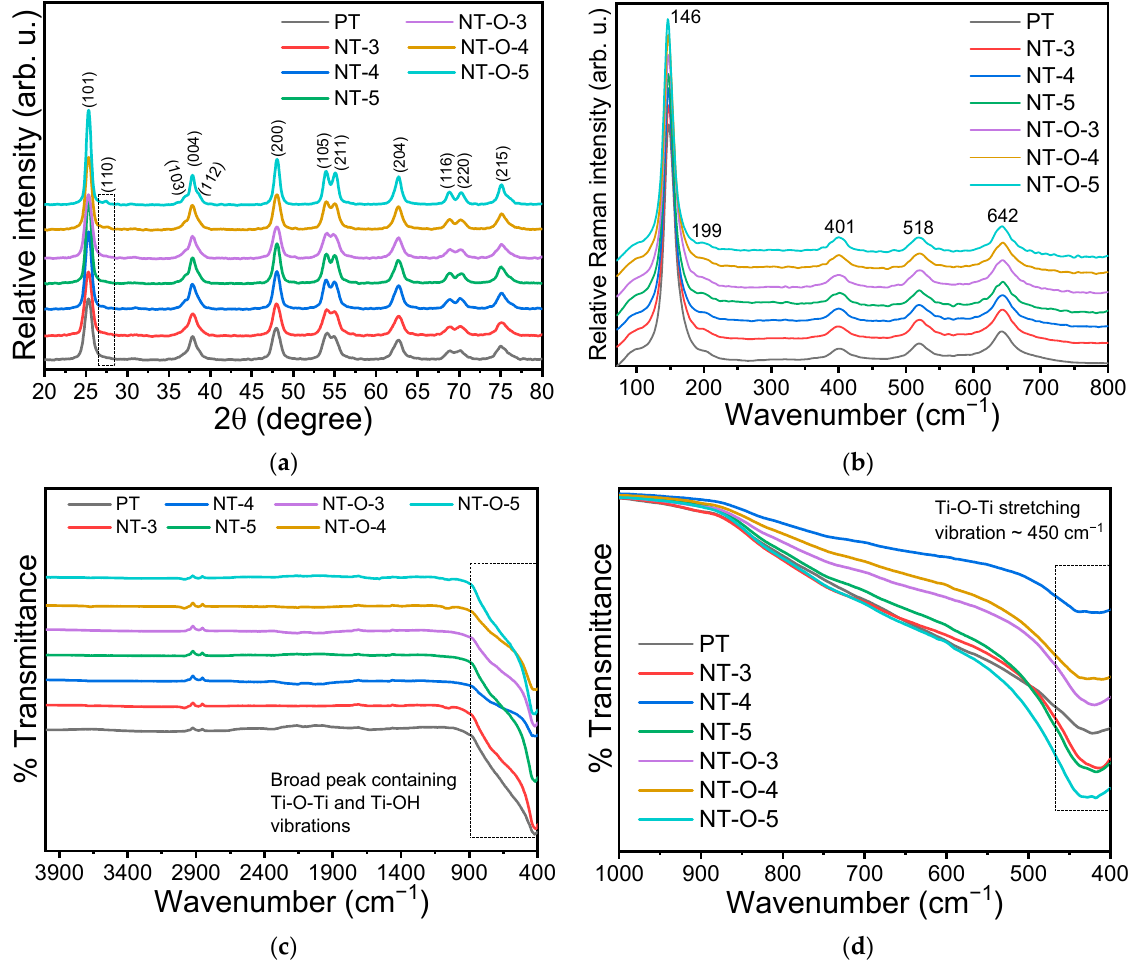
Figure 1. Results of ( a ) XRD, ( b ) Raman, and ( c ) FTIR analyses of investigated solids. Graph ( d ) shows zoomed FTIR spectra in the range of 1000–400 cm − 1 . Table 1. Calculated mass fraction of anatase and rutile (using Spurr equation), the average crystallite size as calculated by